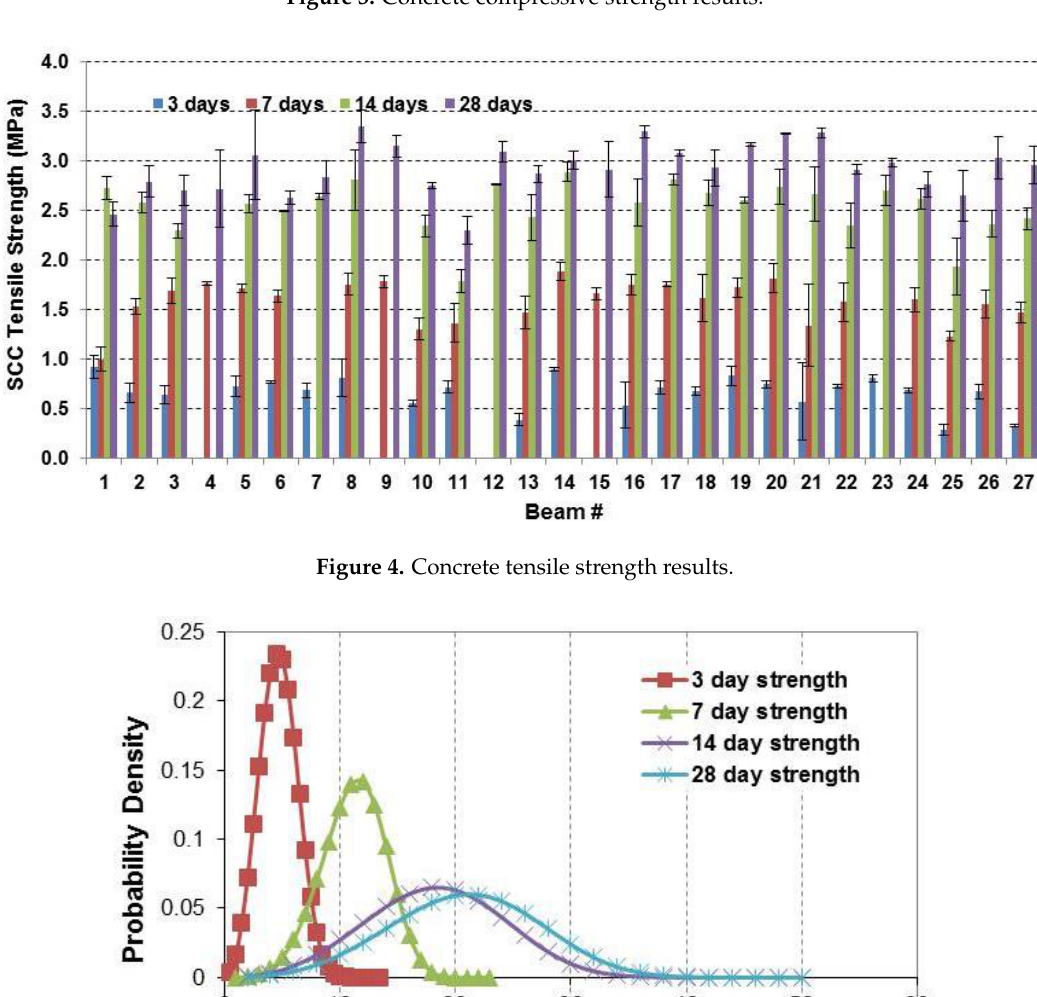
Figure 3. Concrete compressive strength results.